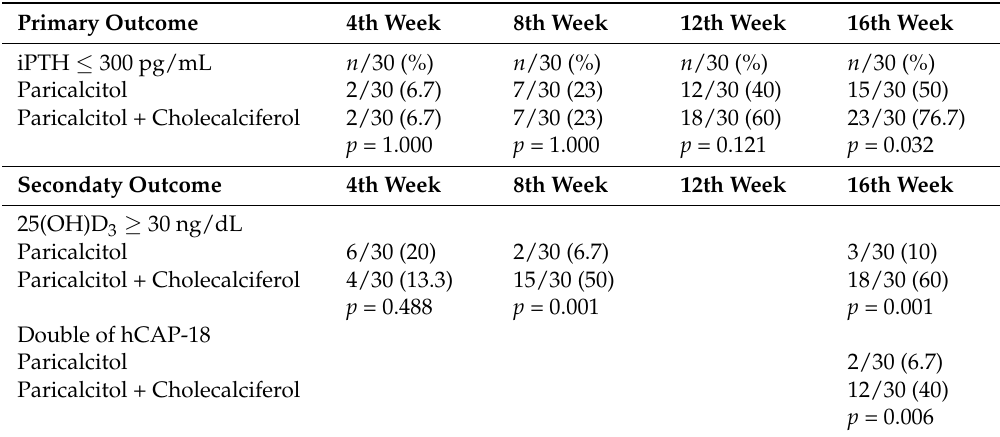
and dual vitamin D treatment